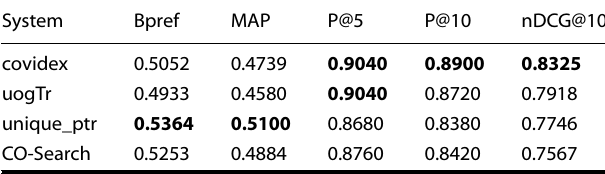
Table 4. Comparison to top automatic runs, using judged